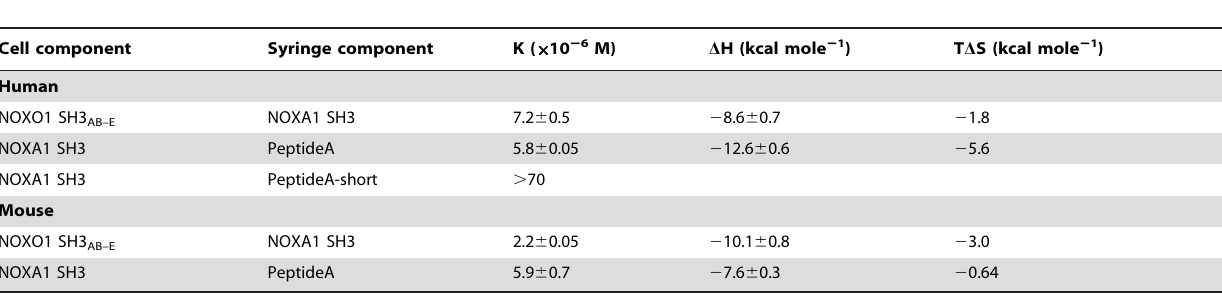
Table 2. Characterisation of intermolecular interactions between NOXO1 and NOXA1.